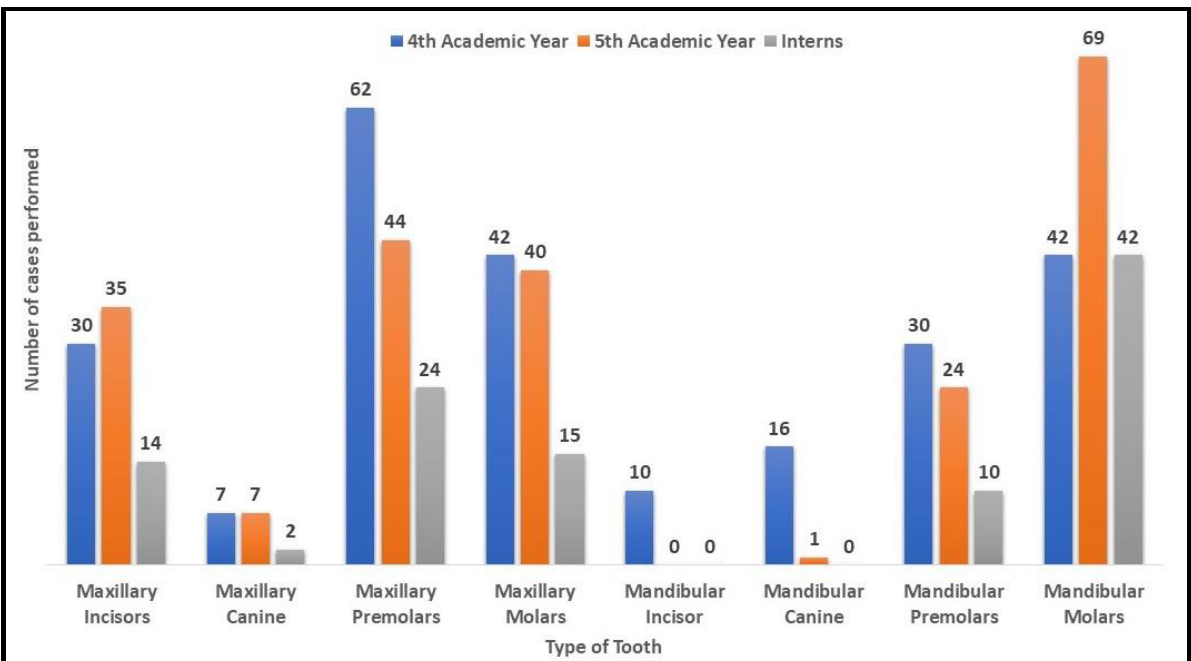
Figure 1. Number of endodontic treatments performed (tooth type-wise) by students of different academic levels.